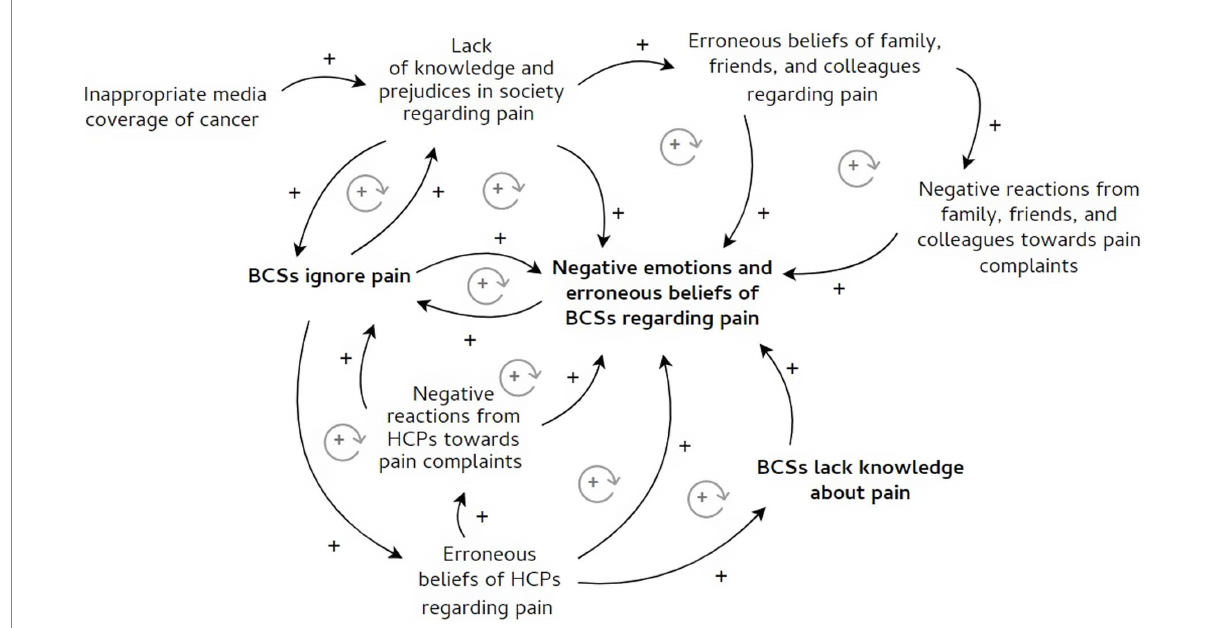
FIGURE 1 Ignoring pain and influencing processes. Figure shows the pattern of ignoring pain and its influencing processes. The processes are located on an intrapersonal, interpersonal, and societal level. The intrapersonal processes are shown in bold. The influencing relationships between processes were translated into words-and-arrows diagrams. The positive arrows represent relationships that reinforce the pattern of ignoring pain. The negative arrows stand for inhibiting relationships. When a relationship is reciprocal, a circular arrow in grey was added. The following abbreviations were used: BCS, breast cancer survivor; HCP, healthcare